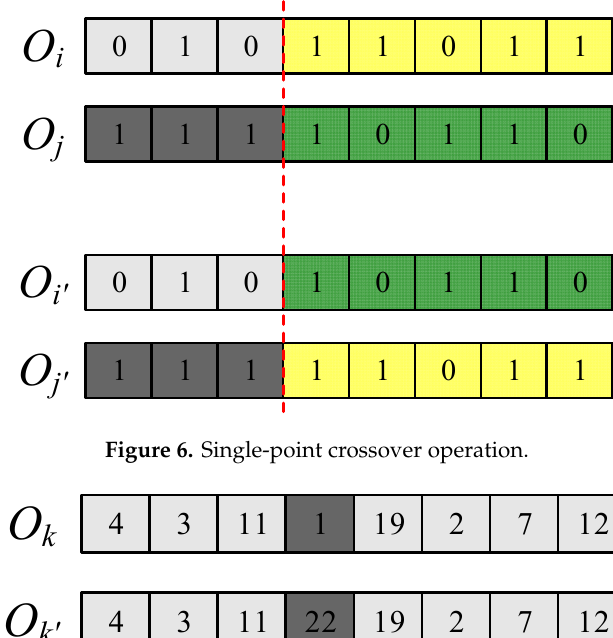
Figure 7. Single-position uniform mutation.